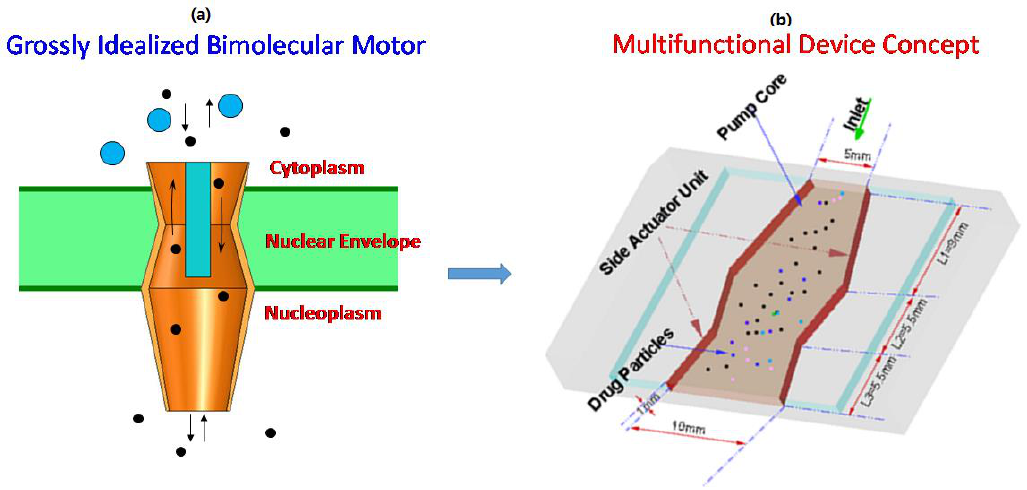
Figure 1. ( a ) Inspiration from grossly idealized biomolecular motor and ( b ) the developed multi-functional device design